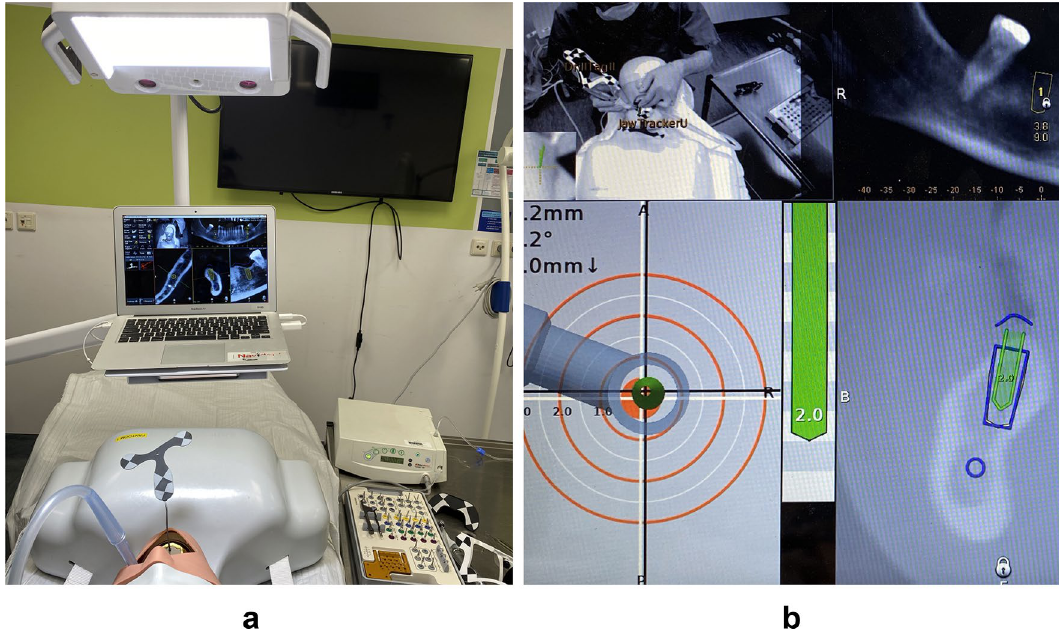
Figure 3. Navigation surgery. ( a ) Overview of navigation system; ( b ) Operation screen displays implant site preparation.